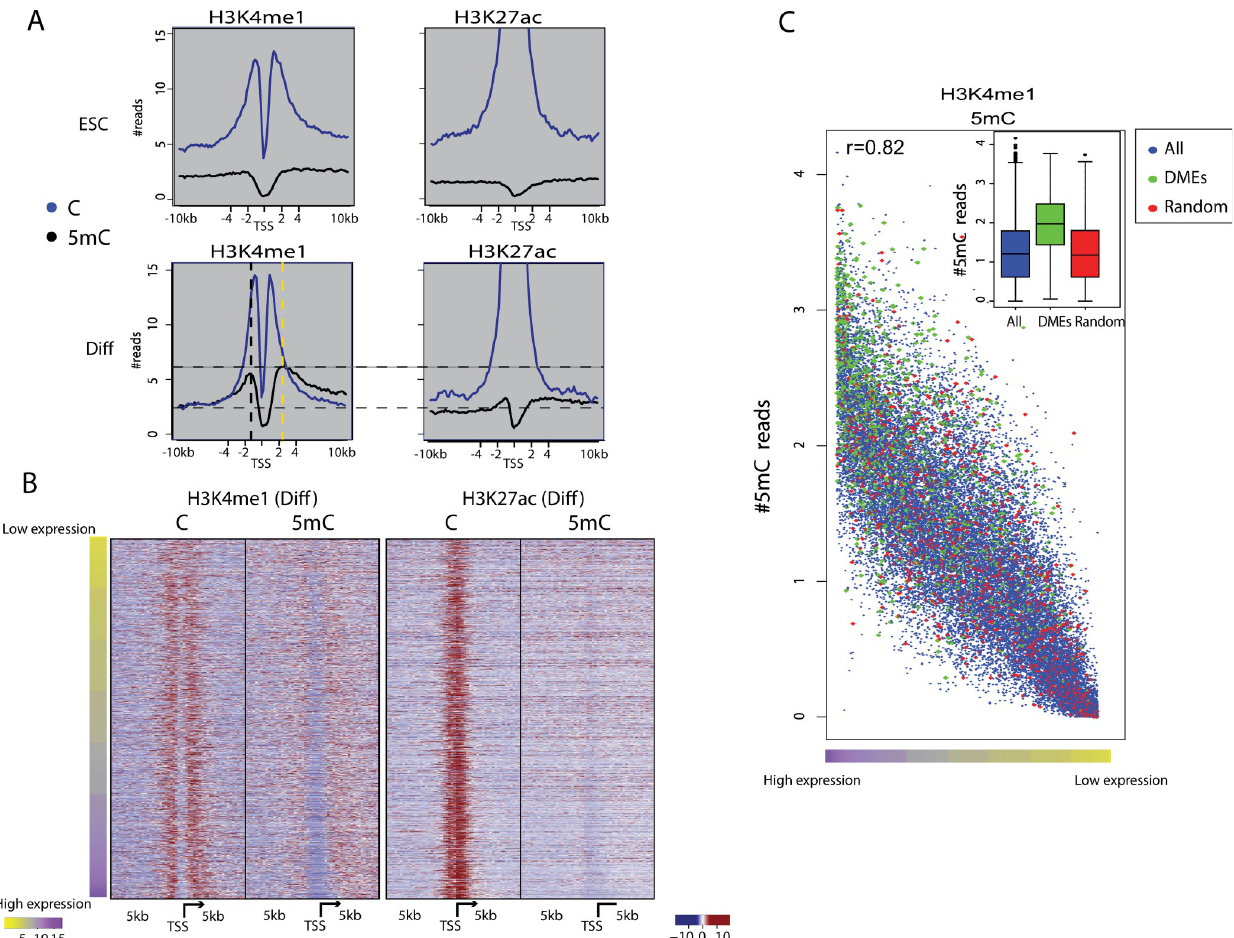
Fig 5. DMEs are associated with high H3K4me1-5mC levels in regions proximal to transcriptional start sites. ( A ) Composite plots of unmethylated (blue) vs. methylated (black) reads of H3K27ac and H3K4me1 maps over ± 10 kb around the TSSs of ESCs and differentiated cells. Vertical dashed lines represent 5mC peak centers (upstream to TSS in black and downstream to TSS in yellow). Horizontal dashed lines represent minimum and maximum of 5mC peaks. ( B ) Heat maps of differentiated cells showing normalized numbers of 5C and 5mC aligned reads within 200-bp bins in the region 5 kb up and downstream of TSSs. To reduce the number of TSSs presented, we randomly selected ~3,500 representative TSSs from ten different expression bins as measured by single-cell RNA-seq. ( C ) Normalized number of 5mC reads around TSSs precipitated with anti-H3K4me1 from differentiated cells plotted from high expression to low expression (left to right on the x axis) for all genes (black), DME-regulated genes (green), and a randomly selected set of genes equal in size to the DME set (red). Boxplots summarizing the same data are shown in the upper right side.